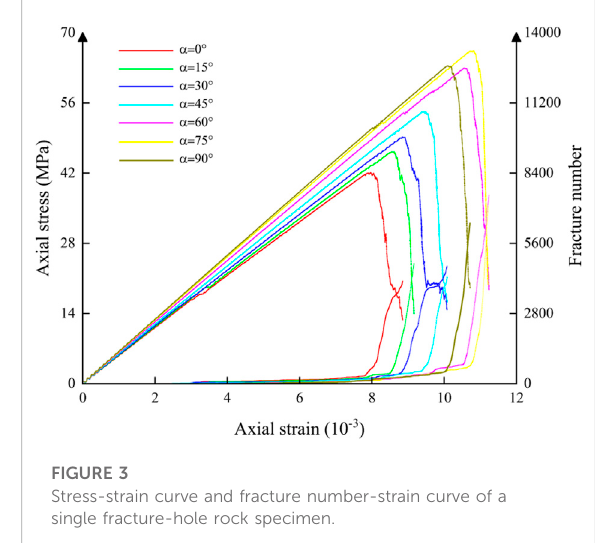
FIGURE 2 Comparison of calibration numerical and experimental results.